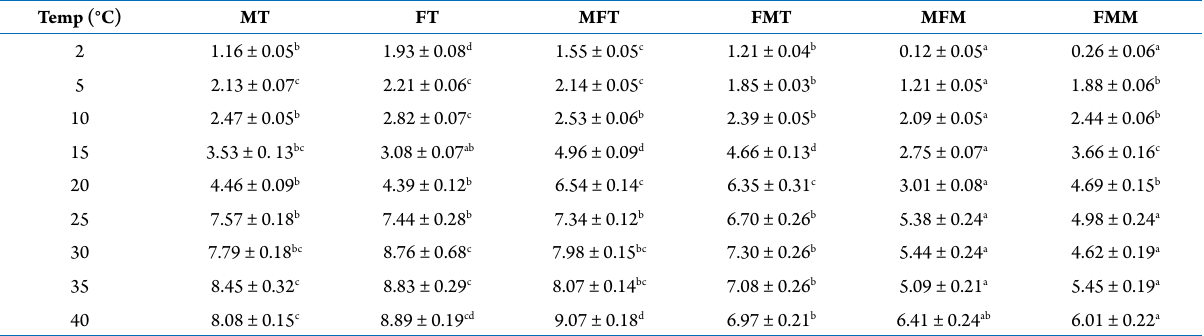
Values with the same superscripts in the same row are not significantly different at the 5 % level Table 2. Swimming activity (cm/sec) (mean ± Standard Deviation) of Branchipus schaefferi under different temperatures. (MT: males in tap water; FT: females in tap water; MFT males in the presence of females in tap water, FMT: females in the presence of males in tap water; MFM: males in female medium; FMM: females in male medium). Temp. (°C) MT